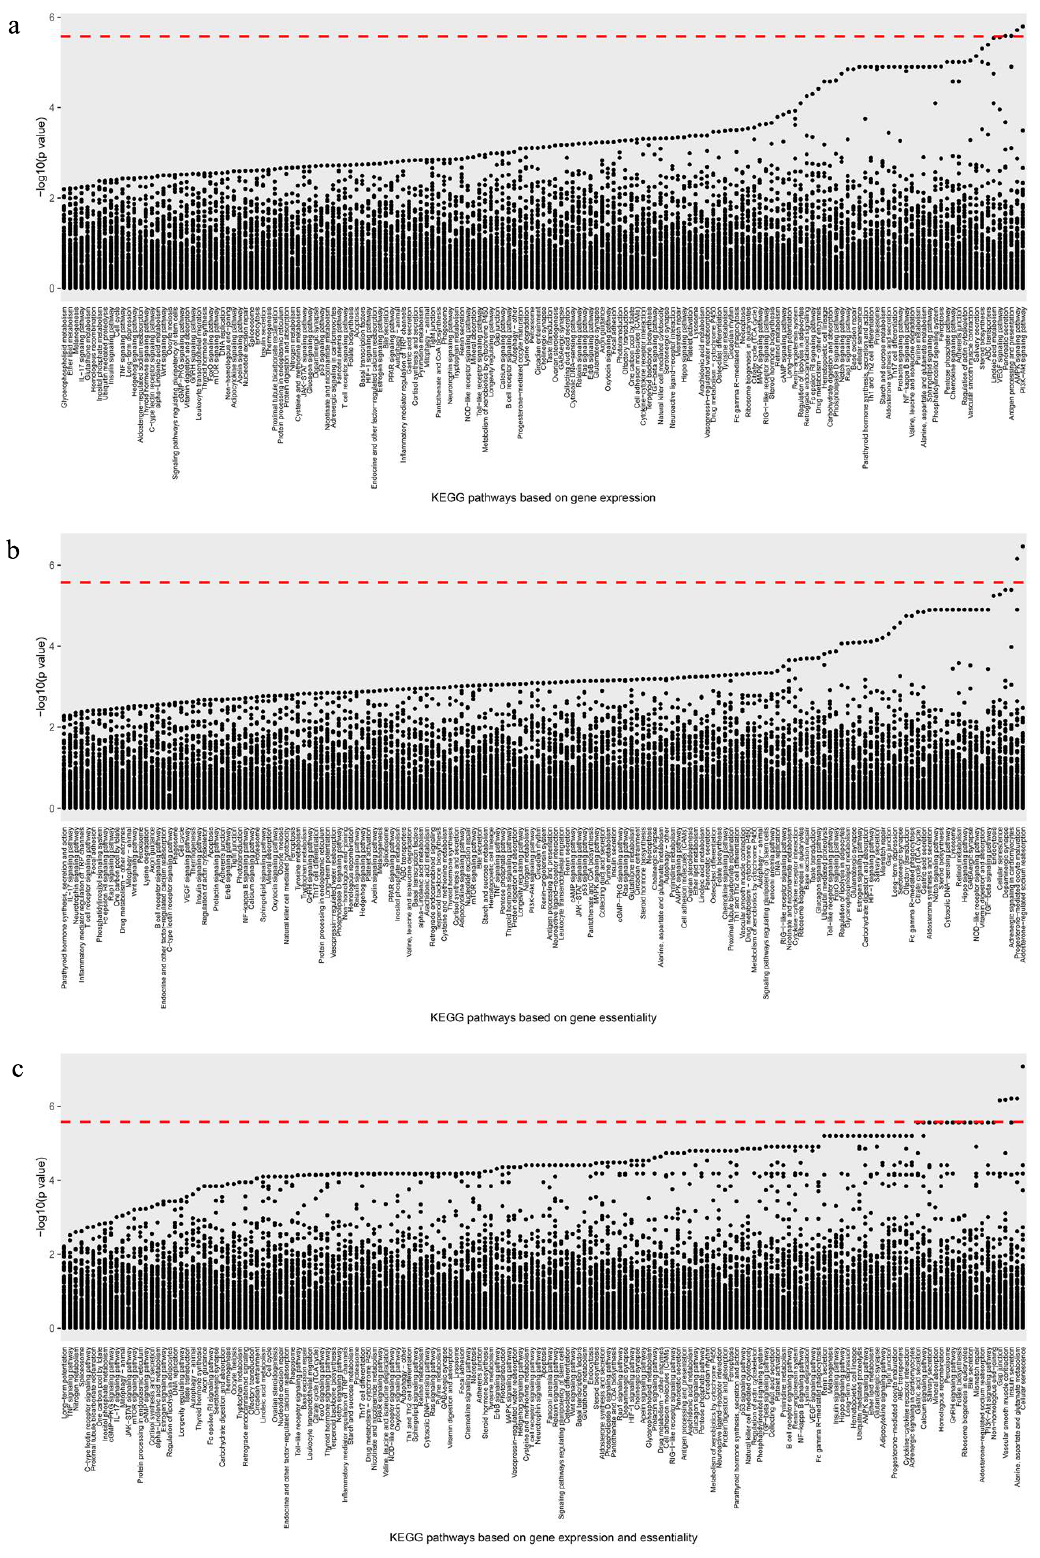
Figure 3. Scatter plots of correlation p -values in Pathway Analysis 3. ( a ) Gene expression data, ( b ) gene essentiality data, ( c ) combined data. In these figures, the X axis represents the pathways, and the Y axis represents the overall p -value (−log10).